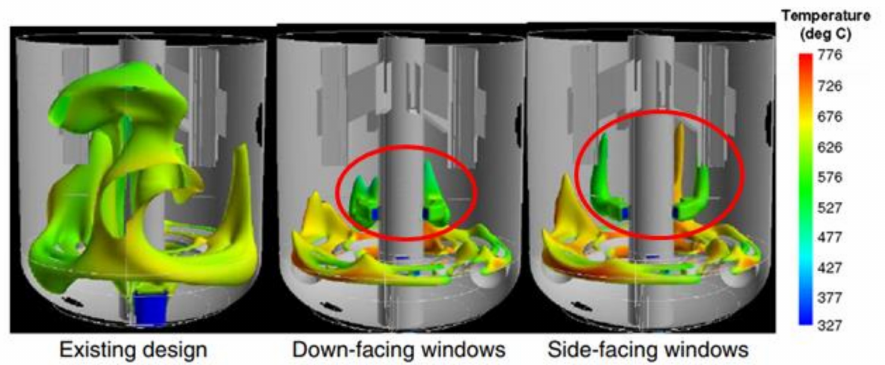
Figure 16. Iso-surface oxygen concentration profile. Adopted from Schwarz and Lee [77].